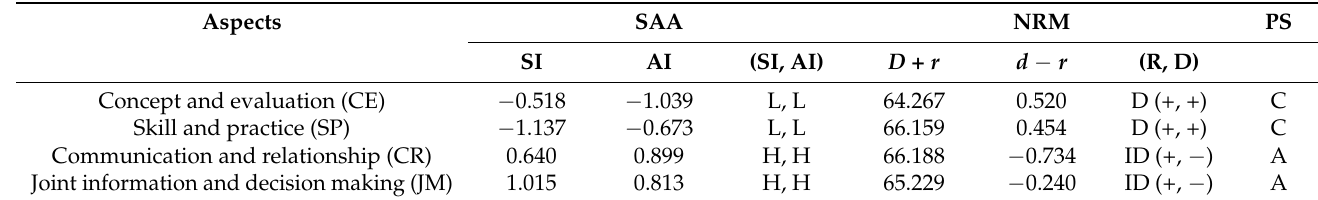
Table 4. The development strategy for competence development of SDM tasks.